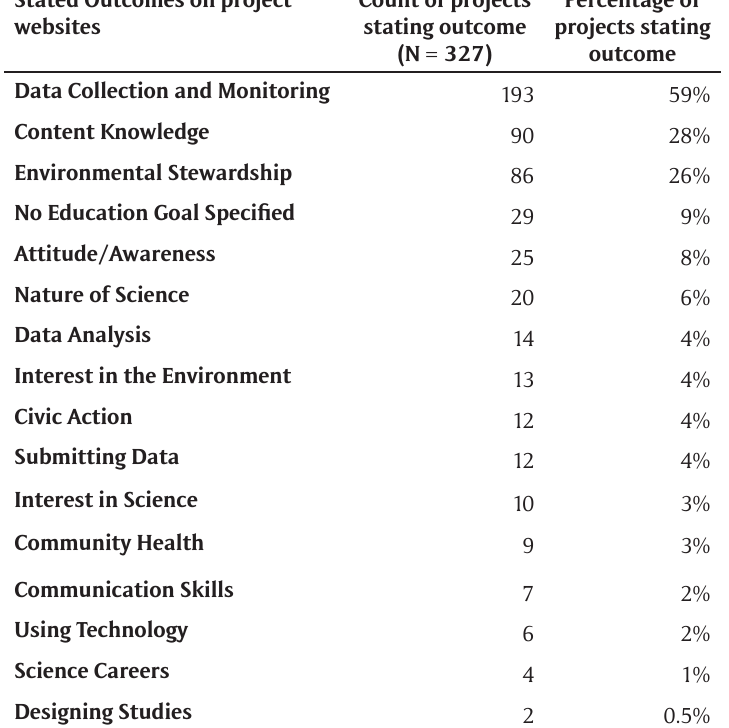
Table 2: Count of specified learning outcomes as coded from 327 citizen-science project websites. Percentages represent the proportion of projects that described the stated outcome. Several projects stated more than one